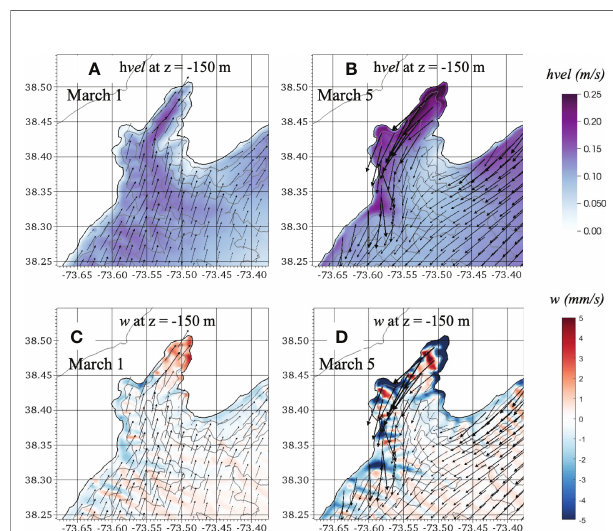
FIGURE 8 | Modeled fi elds of (A, B) horizontal velocity hvel and (C, D) vertical velocity w at the shelf-break depth of z = -150 m. hvel vectors were interpolated from unstructured model mesh ( Figure 2B ) to coarser structured grids for visualization. On March 1, at the peak of the upwelling period, maximum velocities (up-canyon hvel and upward w) were at the canyon head ( Figures 8A, C ). On March 5, at the peak of the downwelling period, the maximum velocities (down-canyon hvel and downward w) spread near the canyon head and along the northeast fl ank of the upper canyon ( Figures 8B, D ). Comparing the two scenarios (March 1 vs. March 5), downwelling had maximum hvel >0.3 m/s and maximum w >15 mm/s, both about twice those calculated during